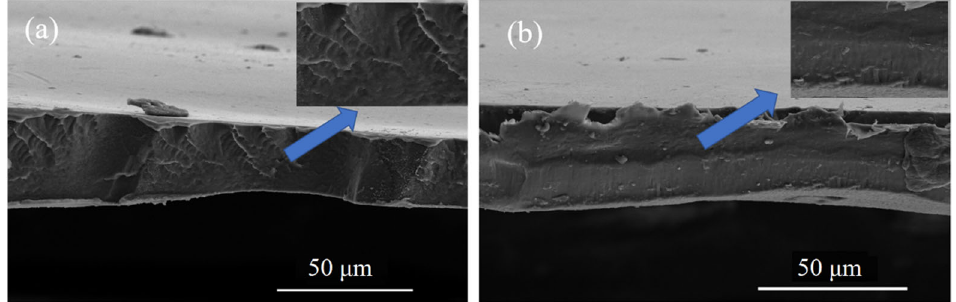
Figure 4. SEM transverse topography of ( a ) pure PVDF film and ( b ) PVDF composite film with 0.3 wt.% CaCl 2